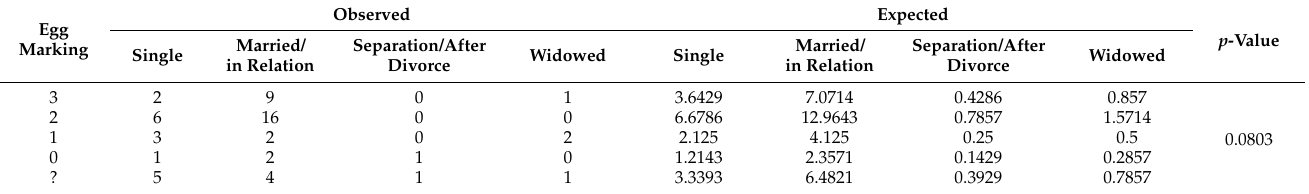
Table 3. The egg marking choices according to the marital status of the respondents.